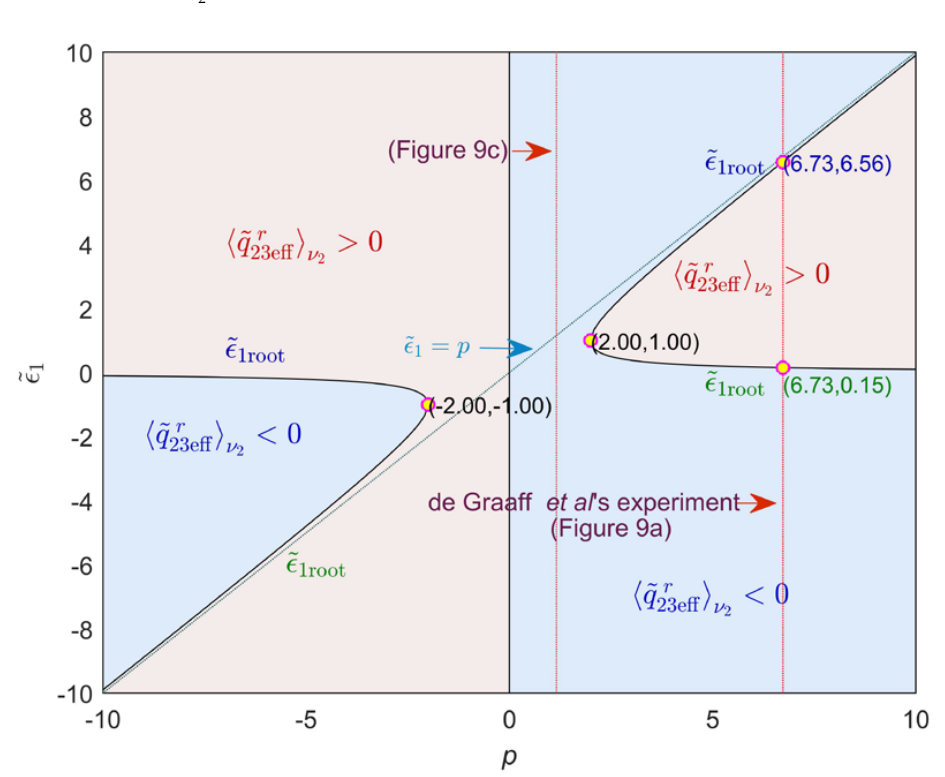
Figure 8. Root map of acting as an interloper and the other two degenerate lower-lying ones (from [36]).